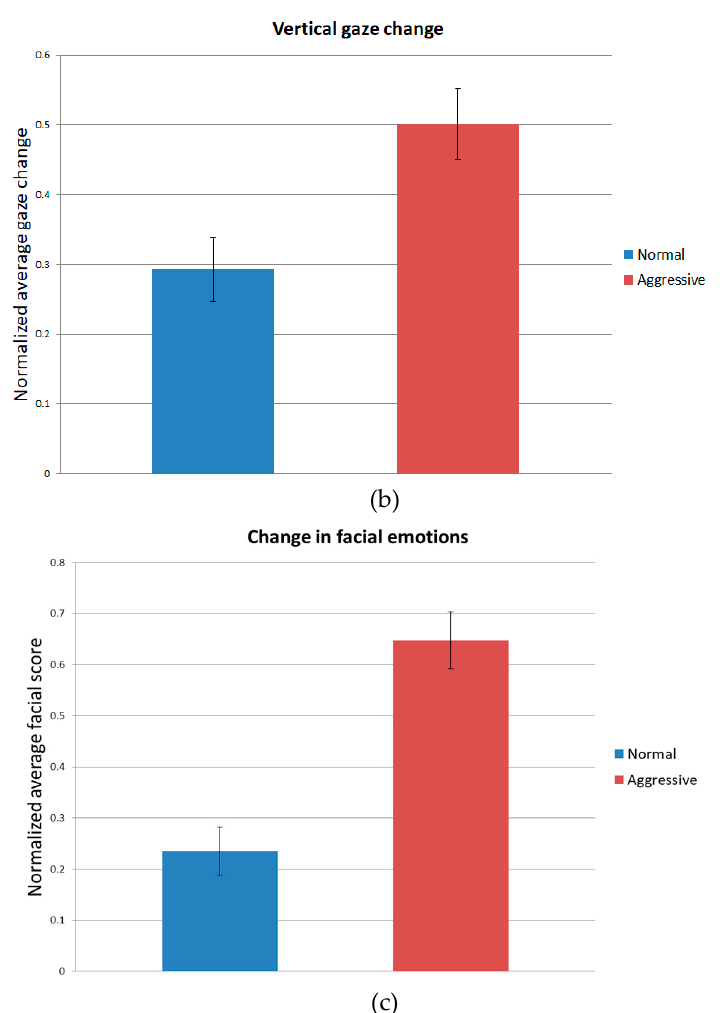
Figure 11. Graphs of mean and standard deviation for three features between normal and aggressive driving: ( a ) Horizontal gaze change, ( b ) Vertical gaze change, and ( c ) Change in facial emotions.